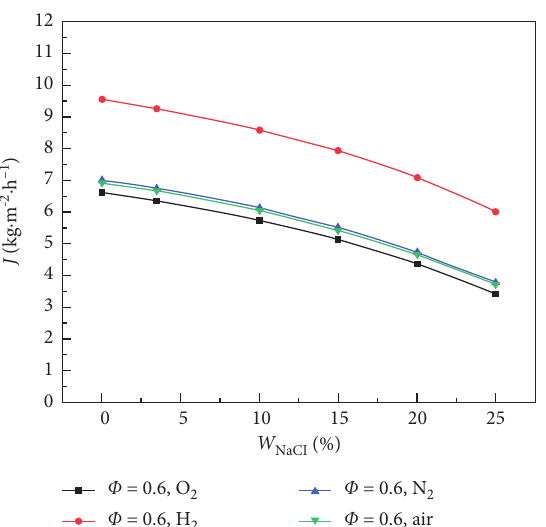
Figure 11: Permeate flux under different NaCl concentration (mass fraction) of the feed side. T V P,in � 0.002m/s, P F � P 0 , P P �